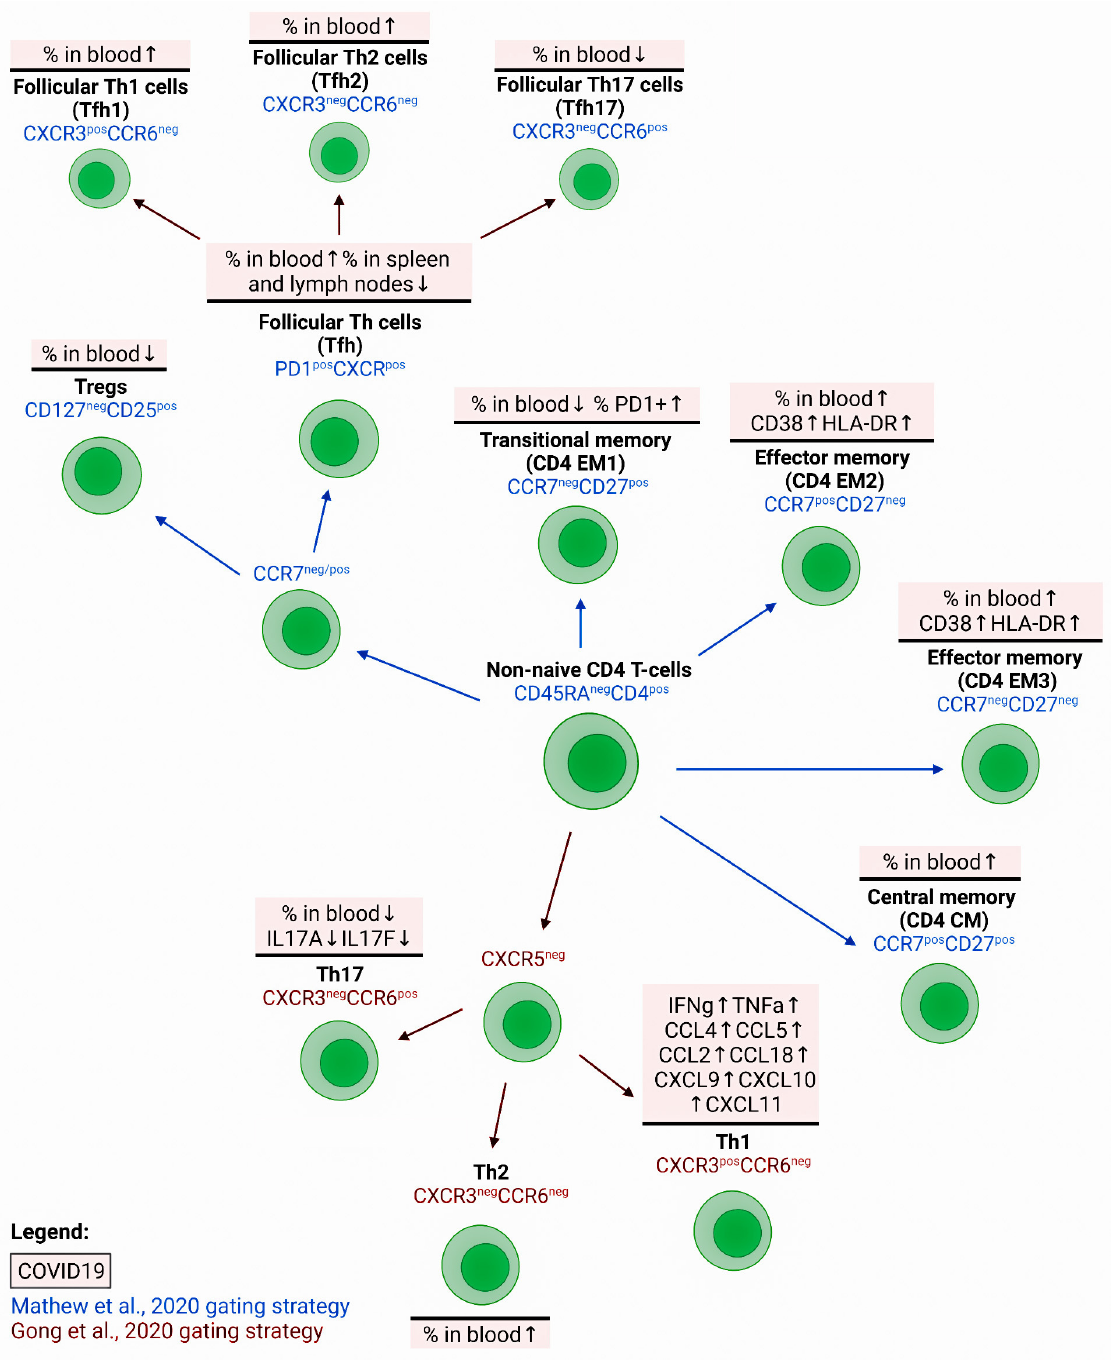
Figure 4. Impairment of peripheral blood Th cell subsets maturation and ‘polarization’ in patients with COVID-19. Abnormalities of Th cell maturation were linked with the decrease in ‘naïve’ CD4 T cells and increase of effector Th cell subsets. The relative number of activated (CD38+, HLA-DR+, or ICOS+) Th cell and their subsets were increased during the acute phase of SARS-CoV-2 infection. An imbalance of ‘polarized’ T cell subsets was frequently found in patients with COVID-19, being characterized by relatively high numbers of Th2 cells and low levels of Th17 and/or Tfh cells. As for the activation markers, the level of CD38 and HLA-DR expression increased on T-helpers of the peripheral blood of COVID-19 patients, with the maximum values of CD38+HLA-DR+ cells found in severe cases [87] (Figure 4). For all non-naive CD4 T-cell subsets (primarily for EM1, EM2, and EM3), an increased number of both CD38+HLA-